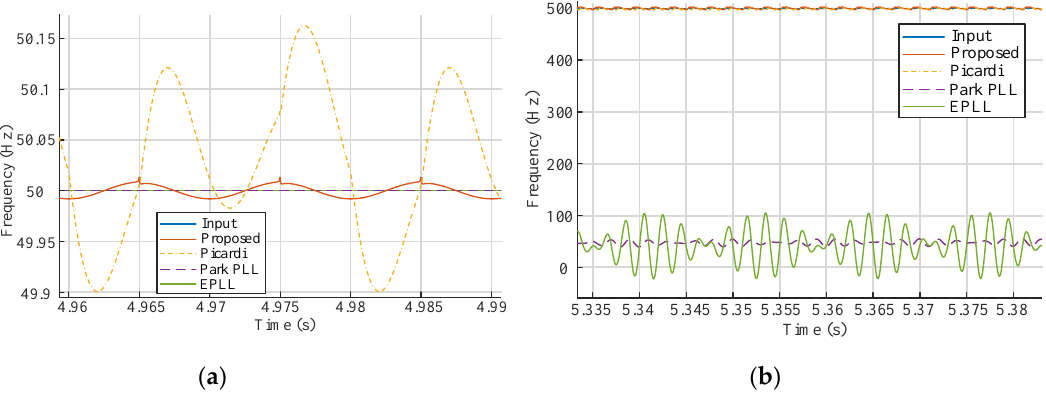
Figure 14. Comparison of frequency detection techniques for a 1 pu input of ( a ) 50 Hz; ( b ) 500 Hz.